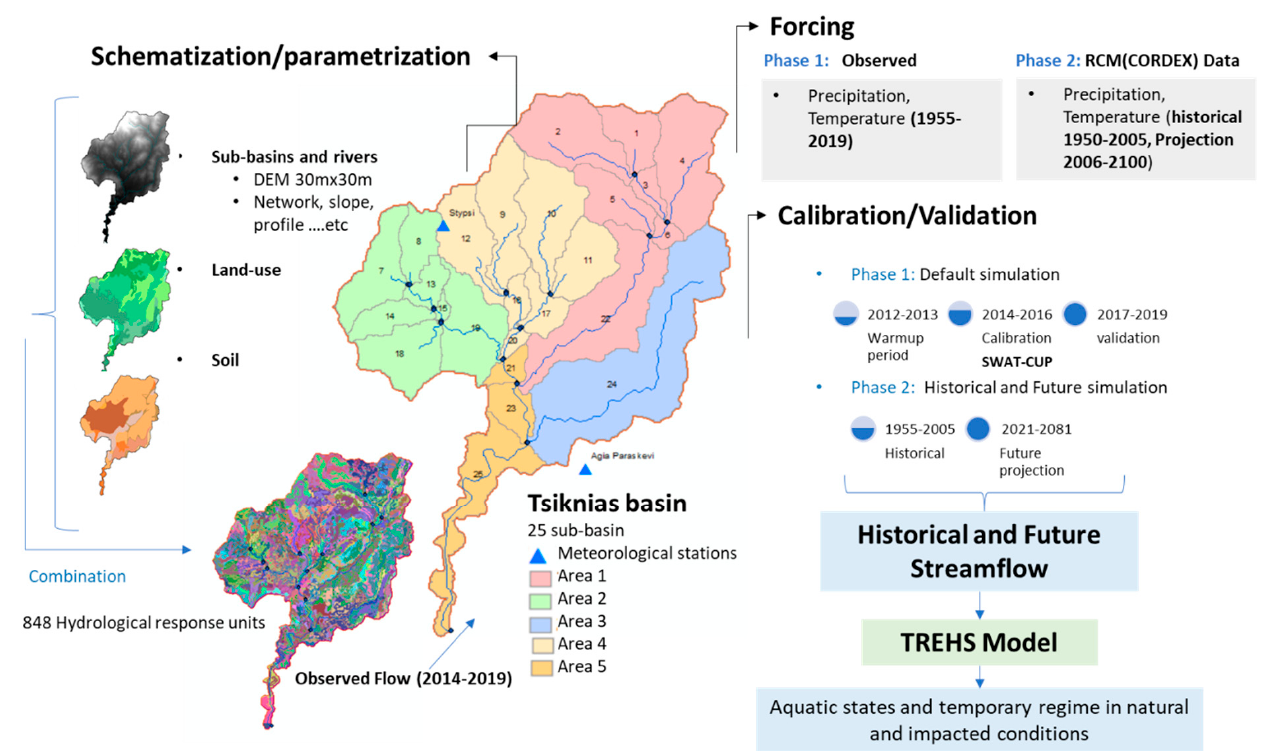
Figure 3. Flowchart of the overall methodology followed.